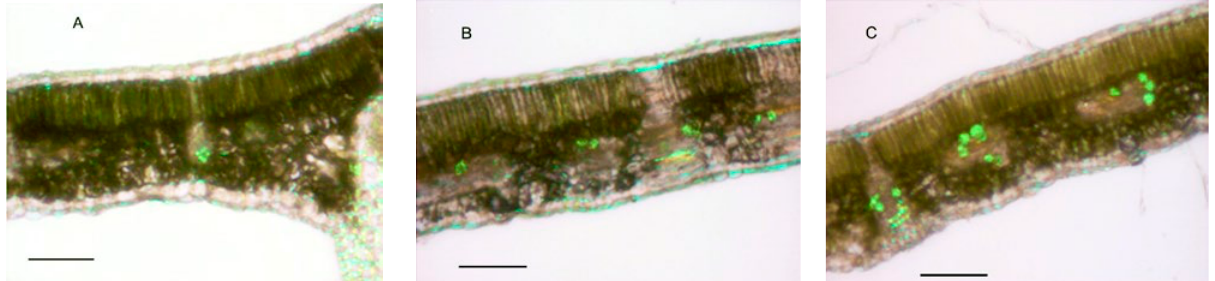
Figure 4. Polarized light micrographs of cross section of leaf of untreated healthy vines (A) and leaf of untreated asymp- tomatic vines (B) showing a druse population at minimum density and leaf of treated asymptomatic vines (C) showing a higher druse number, some of which are near the vascular bundle (arrows). Scale bar: 100 μm.